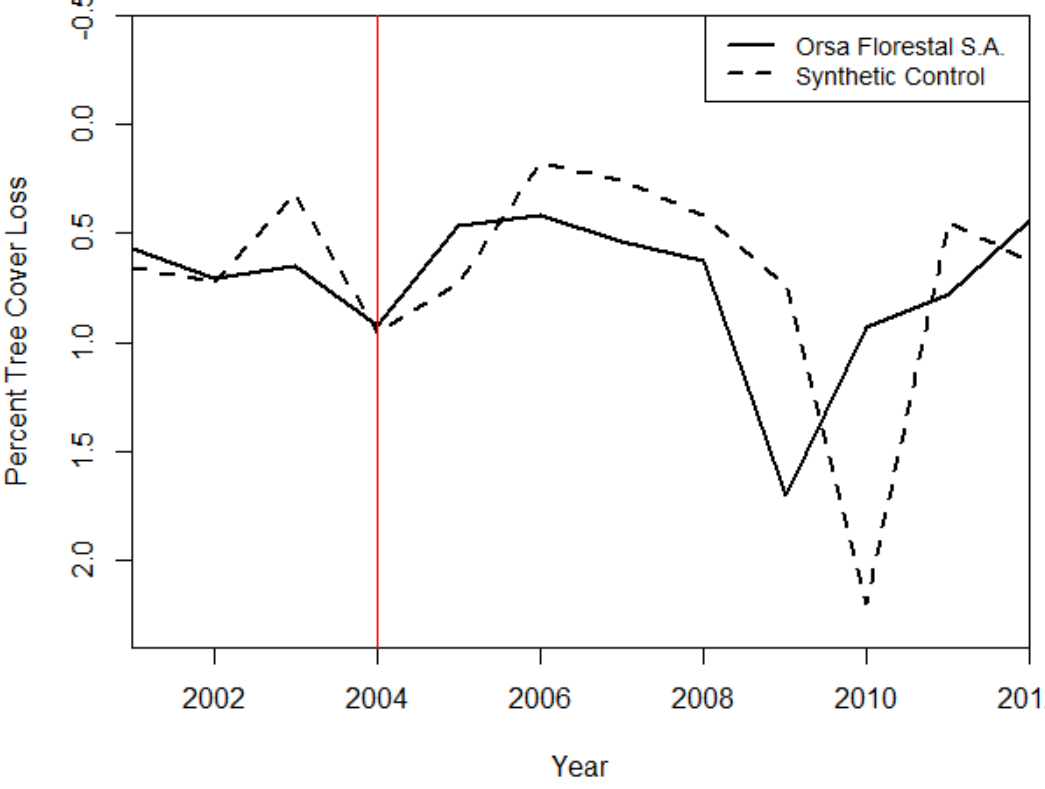
Figure 2. Comparison of tree cover loss in Orsa Florestal S.A. and its synthetic control, 2001–2012. Tree cover loss increases down the y -axis. Red line indicates the year of certification.